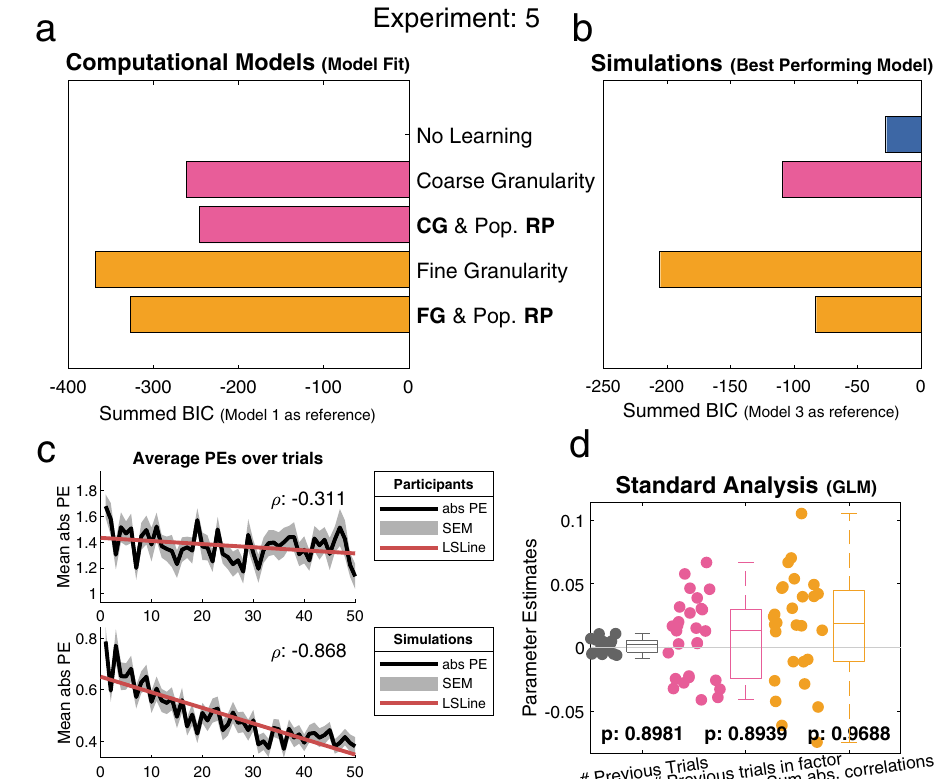
Fig. 7 | Overview of the main analyses for experiment 5. In this experiment participants learned about the German translation of the 50-item International PersonalityItemPool(IPIP). a Model4[FineGranularity]wasthebest fi ttingmodel ( n =28). b Model simulations ( n =28) con fi rmed that Model 4 was the best per- forming model and thus the best strategy to use for this speci fi c experiment. Showing that the Population RP did not add enough information to be useful. c Both plots display the average absolute PEs over time±SEM. (Top) Participants ’ data shows a decrease in the PEs over time ( ρ : − 0.311, least squares line (red)), indicating participants learned over time. Bottom) Simulated data from the best fi tting model (Model 4) shows a large decrease in PEs over time ( ρ : − 0.868). Repli- cating participants ’ learning during the task. d A GLM with three regressors (1 RW